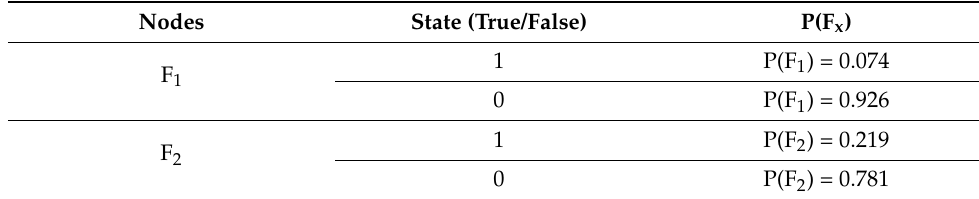
Table 3. The prior probabilities of nodes F 1 and F 2